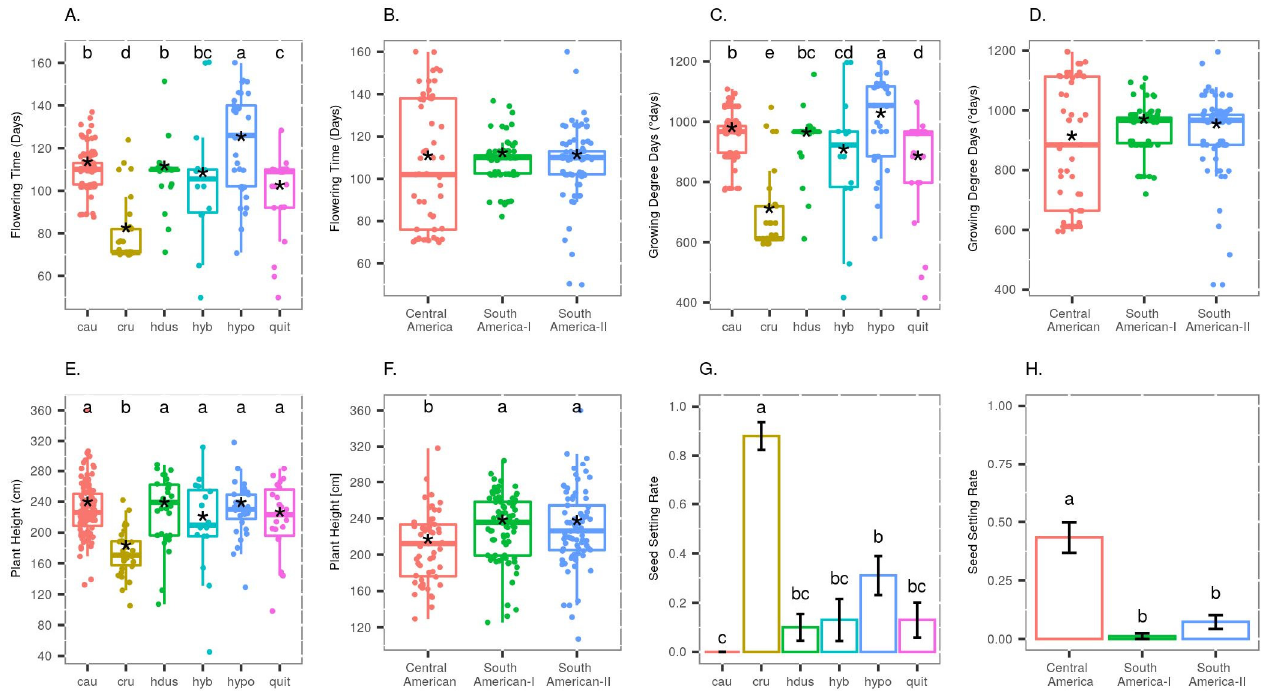
Figure 2. Box and bar plots of four phenotypic traits grouped by species and latitudinal groups ( A – H ), in each box and bar plot the respective groups were compared using a least significant difference (LSD) test and the groups with the different letters were significantly different at alpha = 0.05. There are no letters if there was no significant difference among the compared groups. Black asterisks (*) indicate the mean values of each group in the box plots. Species are: cau, A. caudatus ; cru, A. cruentus ; hdus, A. hybridus ; hyb, the ‘hybrid’ group; hypo, A. hypochondriacus; and quit, A. quitensis .